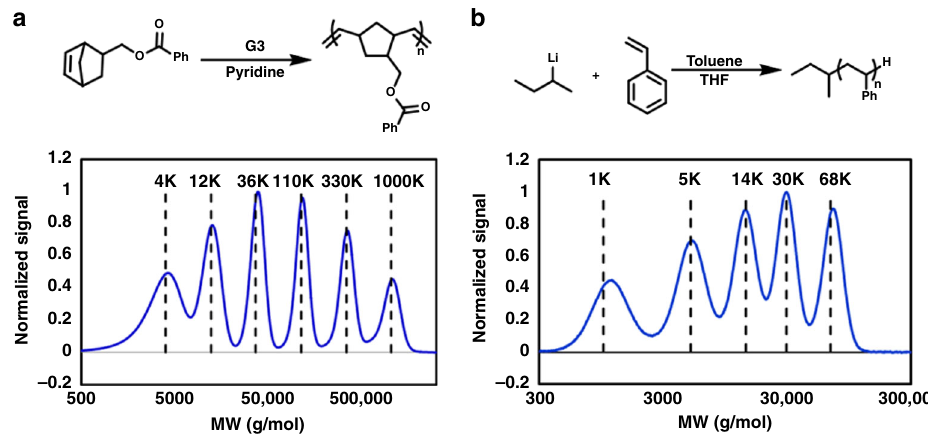
Fig. 6 Chemistry and experimental data for MW sweep in fl ow reactor. a ROMP of a norbornene type monomer with MW sweep chromatogram below it. b Anionic polymerization of styrene with MW sweep chromatogram below it. (dashed vertical lines are the target MWs).